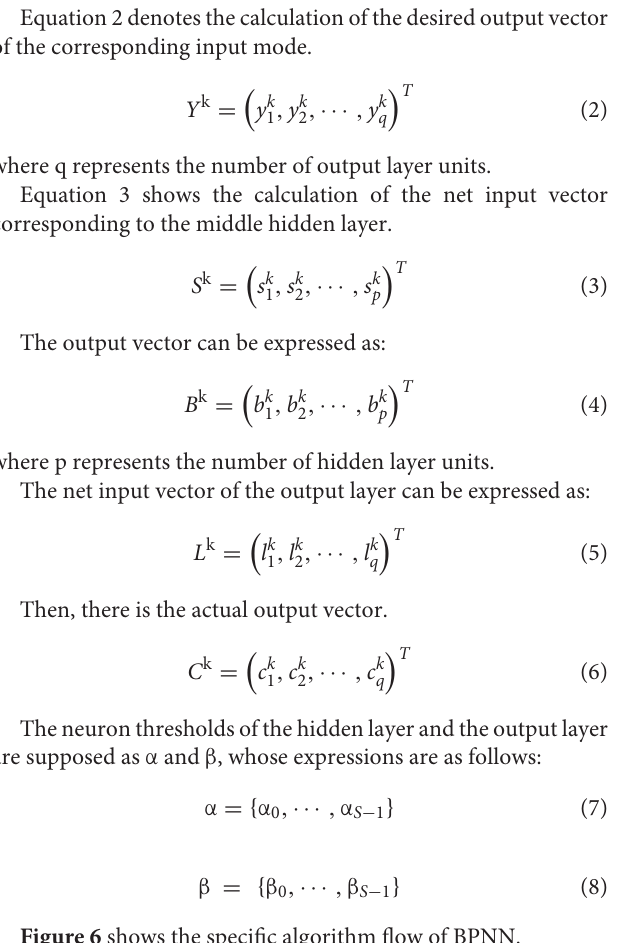
FIGURE 5 | Structure of BPNN.